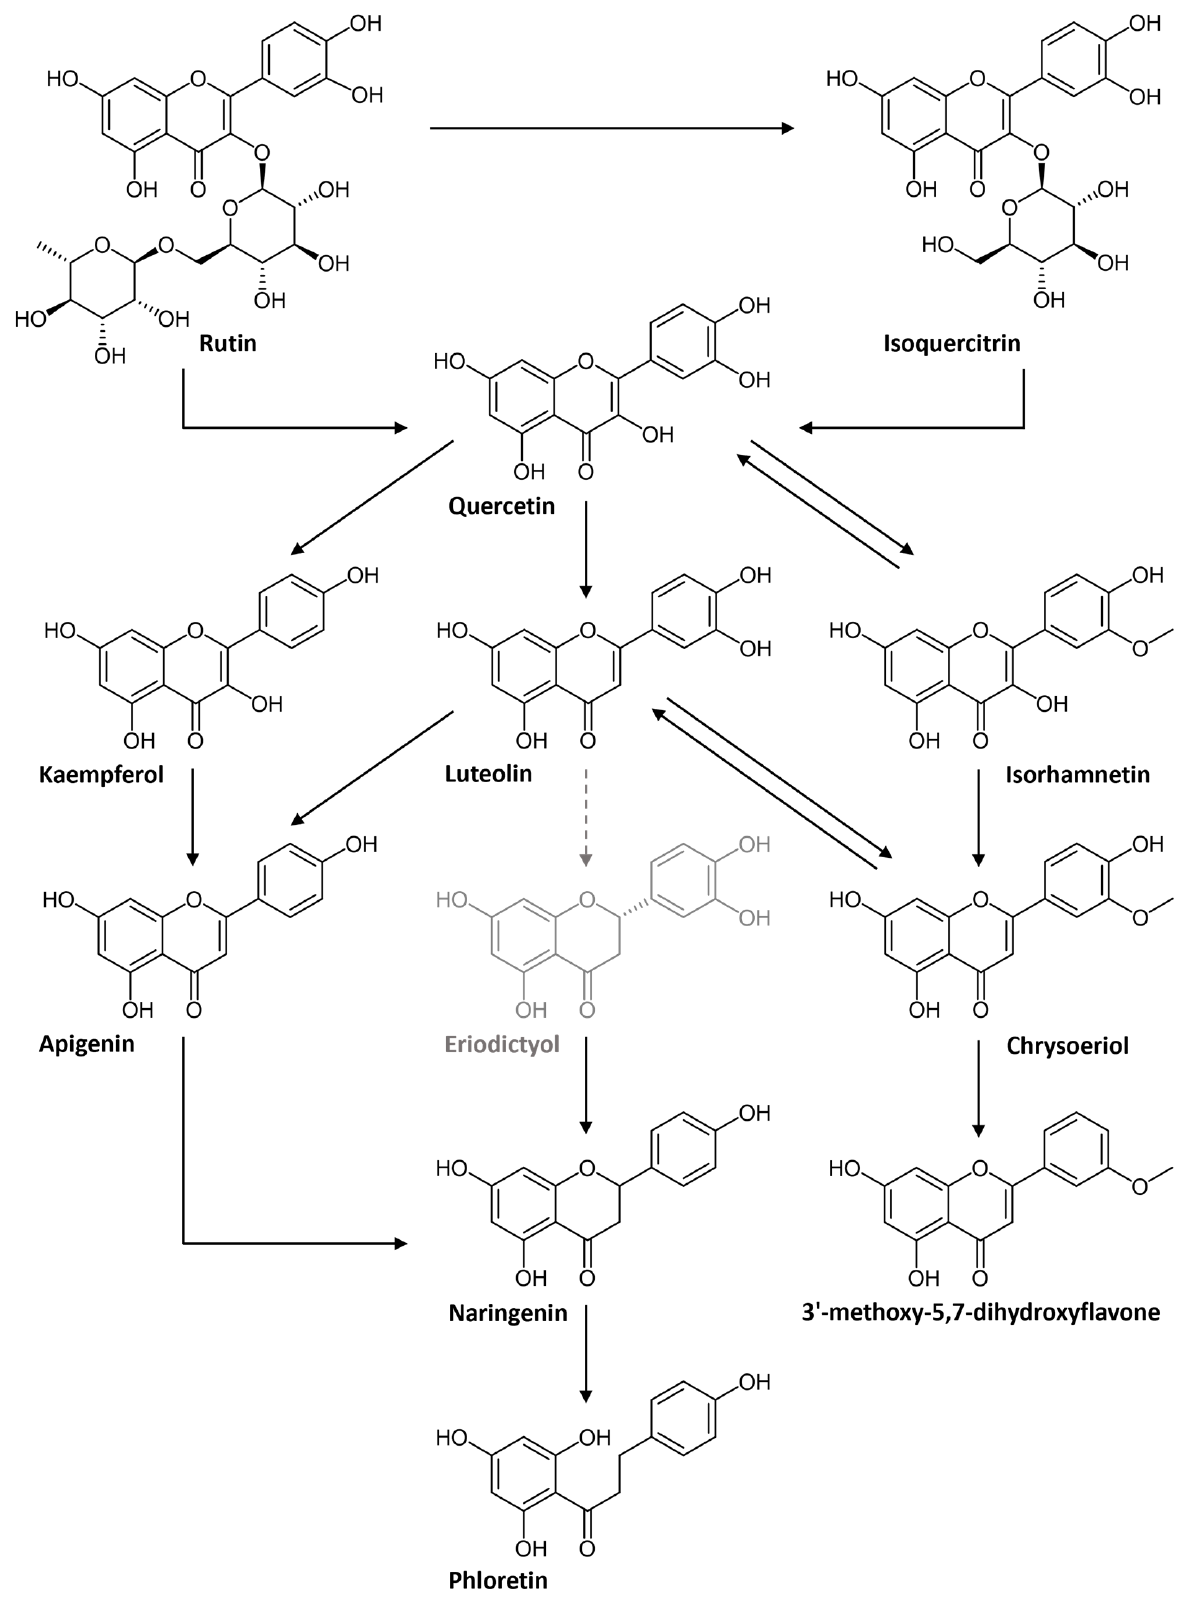
Figure 4. Metabolic pathway of rutin. Detected metabolites are in black; non-detected metabolites are in grey.